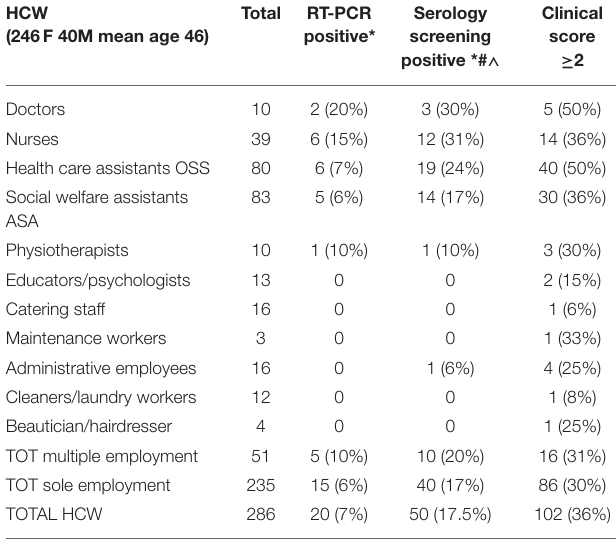
60 days. ∧ Totalserologypositivecorrespondstoall50caseswitheithertestpositiveasnoRT-PCR positive cases with negative serology in this